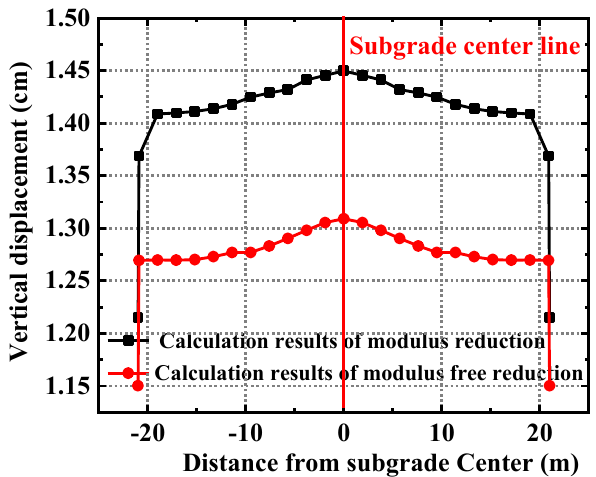
Figure 22. Vertical deformation distribution on the top surface of subgrade.